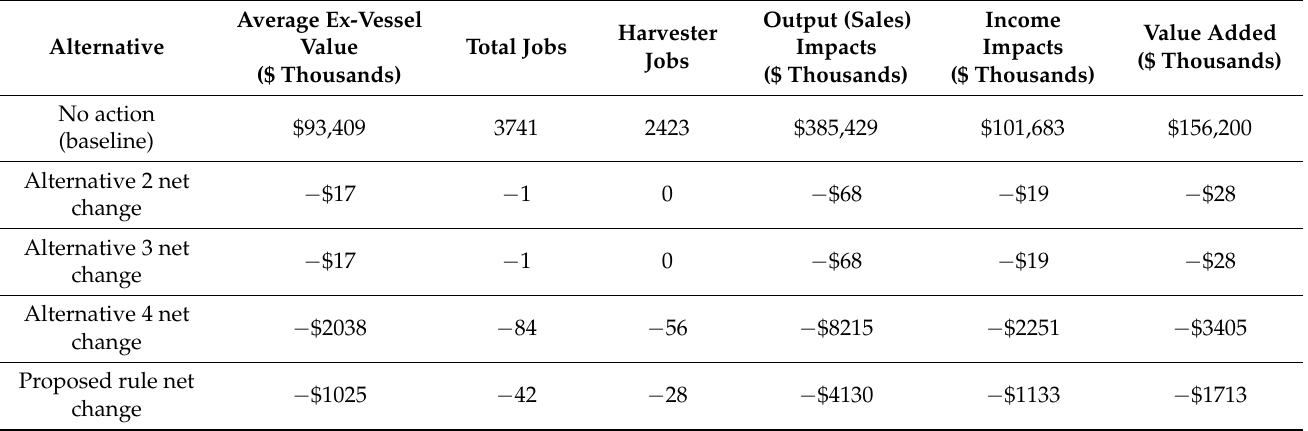
Table 3. Average annual Florida business activity (2015–2019) associated with the commercial sale of finfish and shellfish harvested from trip ticket zones around Monroe County with the expected change from spatial alternatives in 2019